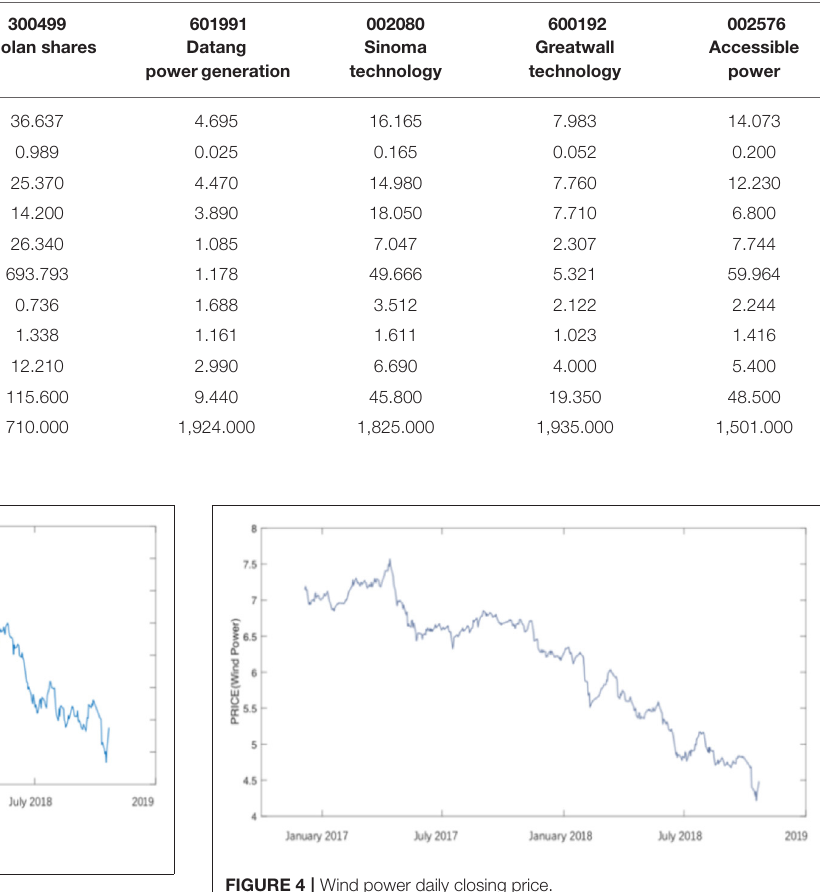
FIGURE 4 | Wind power daily closing price.